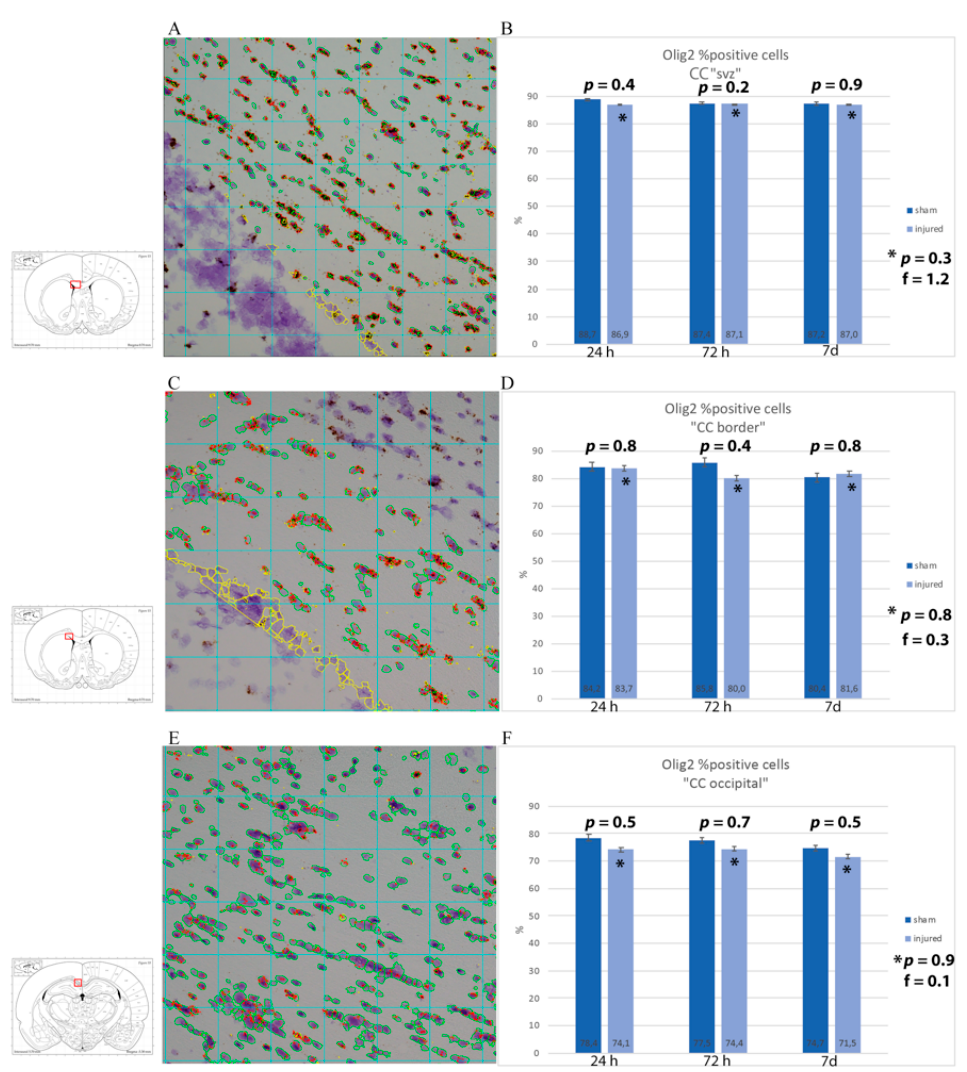
Figure 5. RNAscope analysis with Olig2 mRNA probe of corpus callosum. ( A , C , E ) Sample of RNAscope light microscopy picture of injured subjects set for analysis with Fiji ImageJ. The insert shows the region of interest squared in red, namely ( A ) CC just dorsal of the subventricular zone (CC “SVZ”), ( C ) area of the corpus callosum at around 1 mm from Bregma at the border with the caudoputamen, and ( E ) corpus callosum at around − 3 mm from Bregma. All the cells considered for the analysis are circled in green, while in red are the Olig2 probe clusters. In yellow is what has been manually excluded because it was considered as background / not part of the region of interest. ( B , D , F ) Results from the image analysis are presented as averages of the percentages of the number of cells expressing Olig2 mRNA out of the total number of cells from each subject in the ROI. While a trend with a lower number of Olig2 was observed in injured as compared to sham, such a di ff erence was not statistically significant at any timepoint. * p indicates results from one-way ANOVA analysis, while p is from Student t -test.